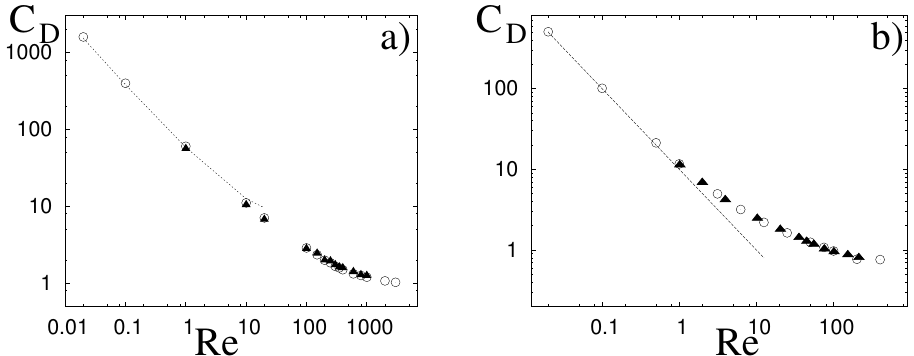
Figure 5. Drag coefficient as function of the Reynolds number: ( a ) ◦ torus at Γ = 0.1, filled (cid:52) circular cylinder (data from [10] analytical expression C D = 8 π / [ Re d log ( 7.4/ Re d ) with Re d = Re Γ ; ( b ) ◦ torus at Γ = 1, line C D = E / Re with E = 10. filled (cid:52) data for the same flow from